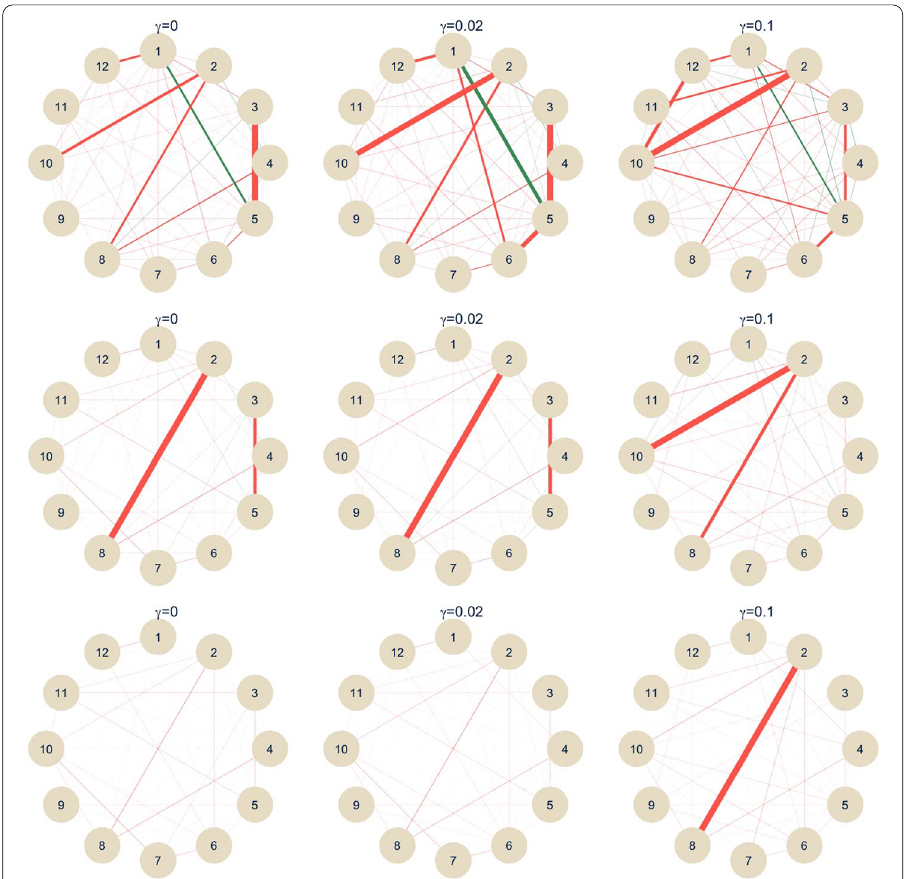
Fig. 5 Conditional correlations around June 30 2017, using the bandwidth parameter h = 20 (first row), h = 50 (second row) and h = 100 (third row). The parameter γ refers to the robustness parameter: γ = 0 means no robust